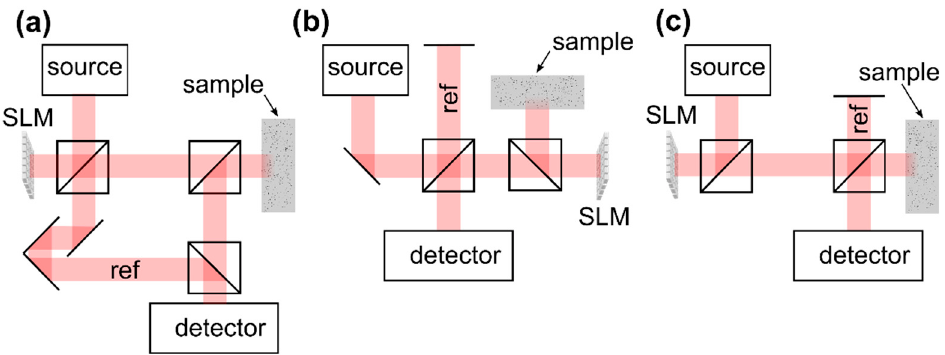
Figure 9. Optical coherence tomography (OCT) designs enabling wavefront manipulation. ( a ) Mach–Zehnder design. The SLM manipulates the sample beam only [68,82–86]. ( b ) SLM at sample arm. The sample beam passes the SLM again after reflection at the sample [70]. ( c ) SLM at source beam. The sample and the reference beam are affected simultaneously by wavefront manipulation with the SLM [71,87–89]. Abbreviations: SLM —spatial light modulator, ref —reference beam. Image from [8], with permission.